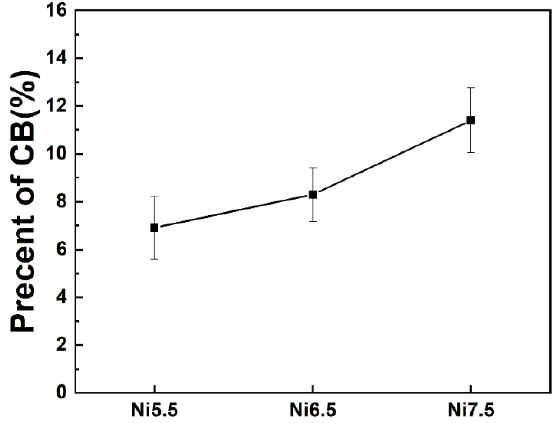
Figure 6. The area fraction of CB in the deposited metals.